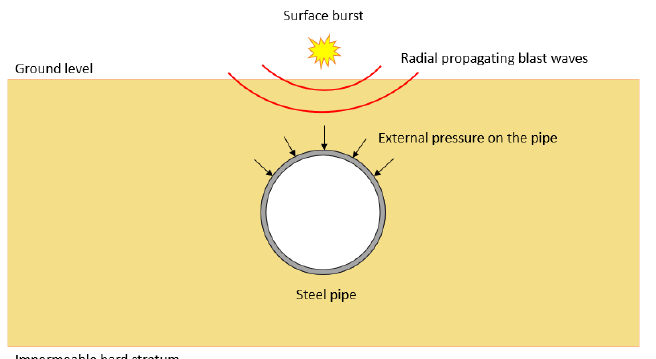
Figure 2. The simplified analytical modelling of the pressure on pipe due to surface blast loading.